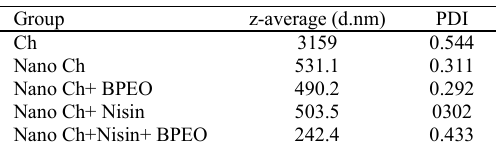
Table 2. Particle size and distribution of different Nano- emulsion coatings